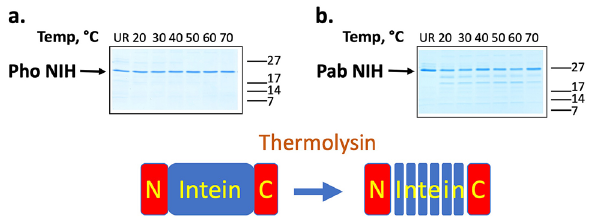
Figure 3. Analysis of intein stability of the Pho PolII and Pab PolII inteins by temperature-dependent thermolysin digestion. Precursor intein fusion protein NIH-C1A-QACA of ( a ) Pho PolII or ( b ) Pab PolII was incubated in buffer C first for 10 min and then for 1 h after the addition of 30 ng/mL thermolysin at the indicated temperatures, and analyzed by SDS-PAGE stained with Coomassie blue. Lane UR is unreacted